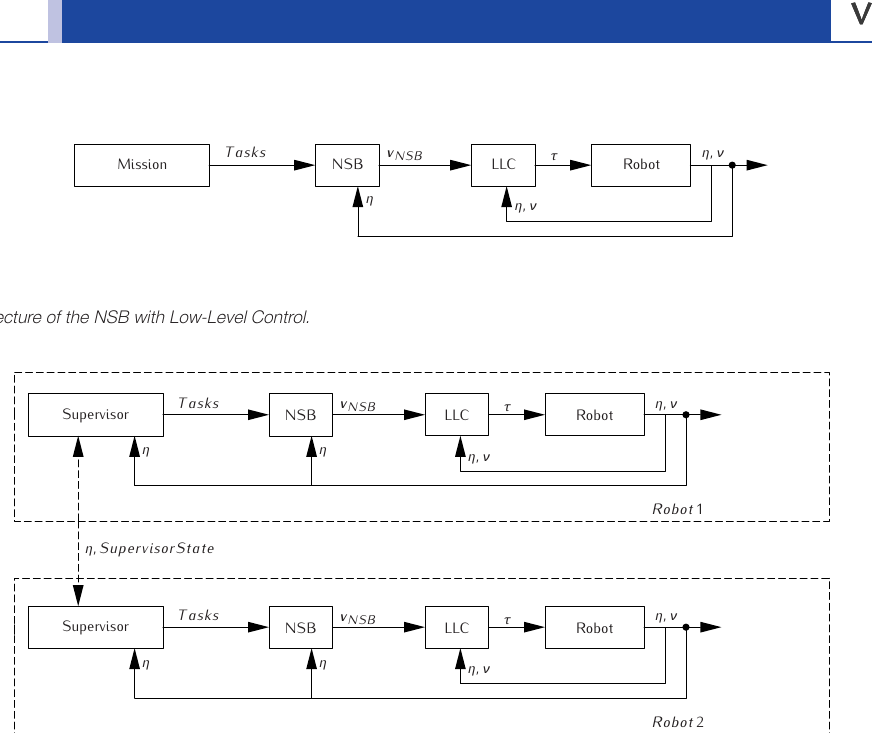
Figure 4. Sketch of the control architecture with two cooperative